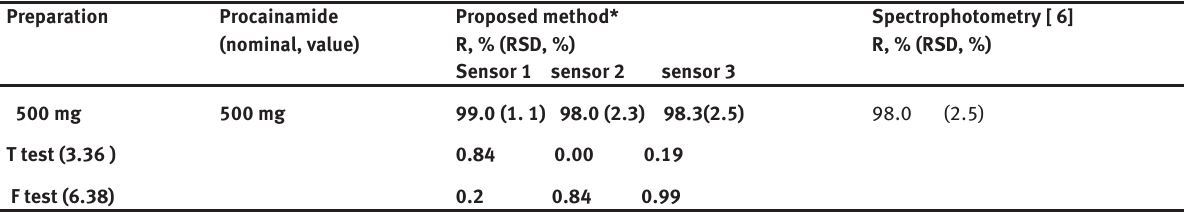
Table 5 : Determination of procainamide in its pharmaceutical formulation using the procainamide sensors.